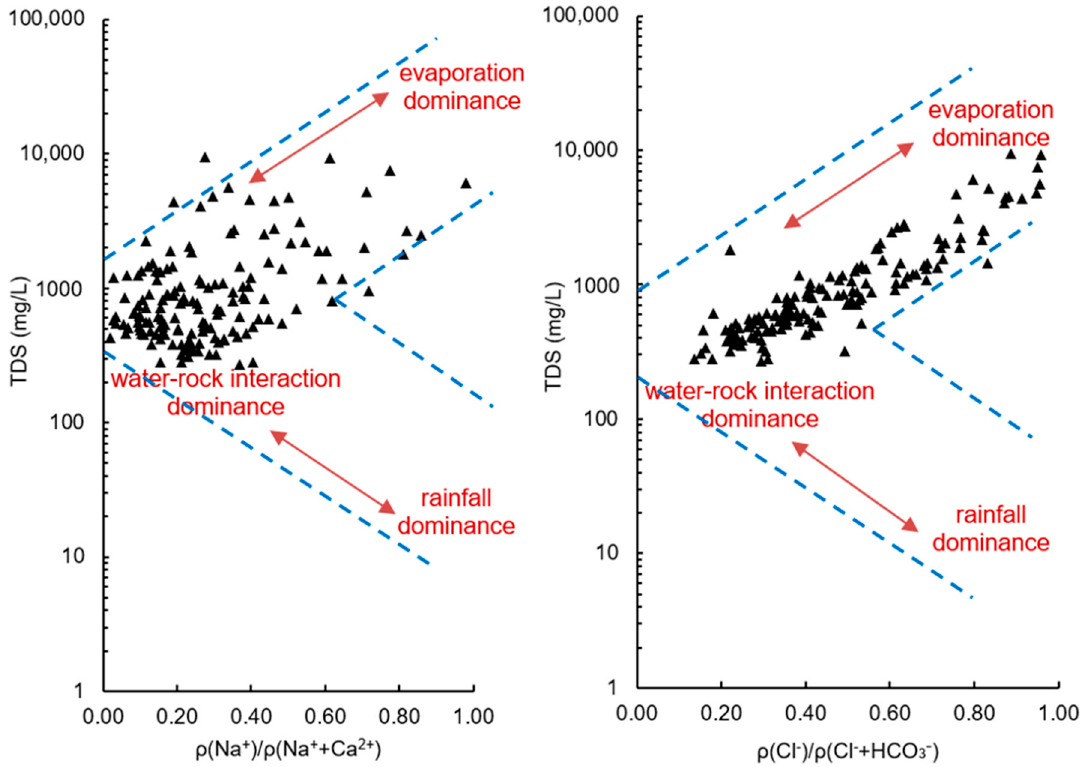
Figure 13. Gibbs diagram of the groundwater